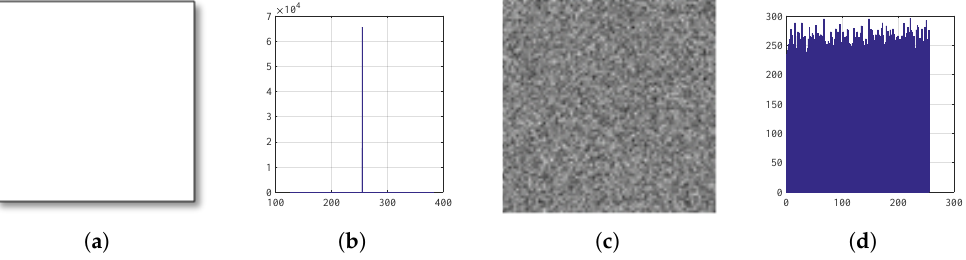
Figure 16. Histograms: ( a ) White image, ( b ) histogram of plain White, ( c ) encrypted White, and ( d ) histogram of encrypted White.